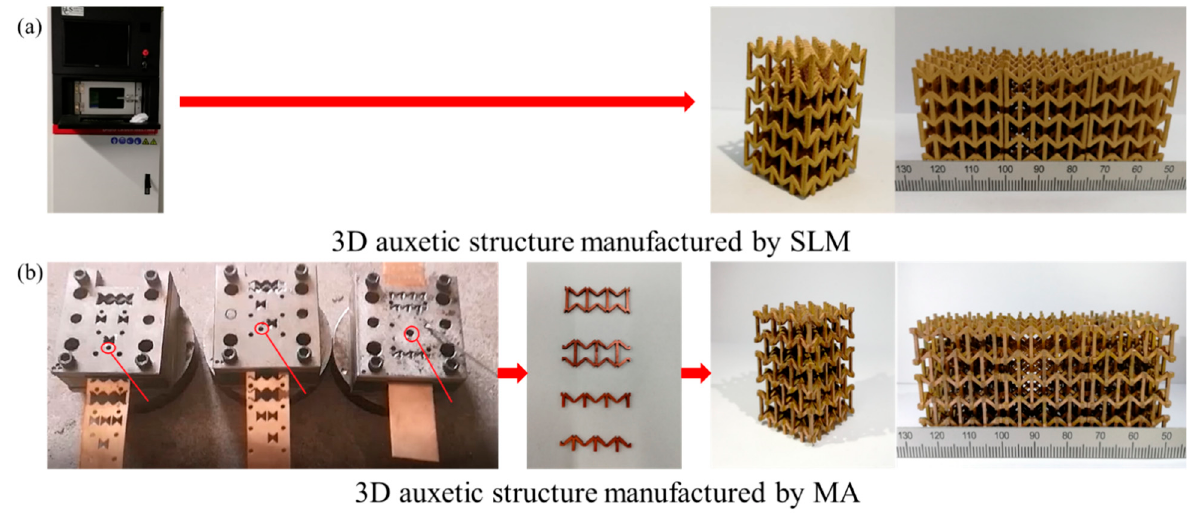
Figure 2. 3D auxetic strcutre manufactured by ( a ) SLM and ( b ) MA.